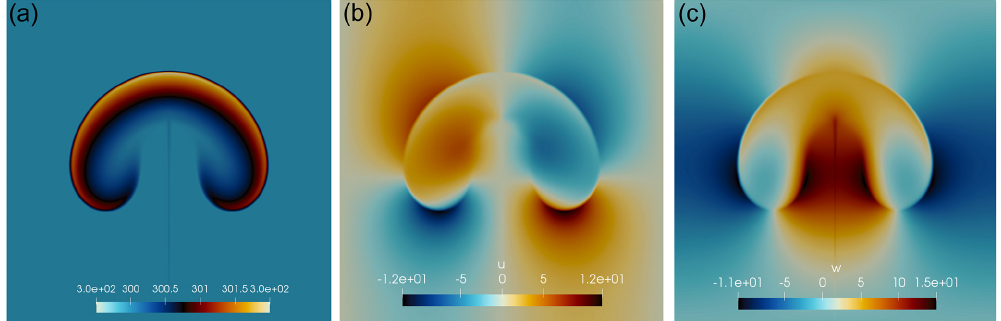
Figure 2. 2.5D rising thermal bubble with effective resolution (cid:49)x = (cid:49)z = 15 . 625m and N = 4. Panels depict (a) potential temperature θ , (b) horizontal velocity u , and (c) vertical velocity w at t = 1000s in (cid:127) = 10 × 10km 2 .